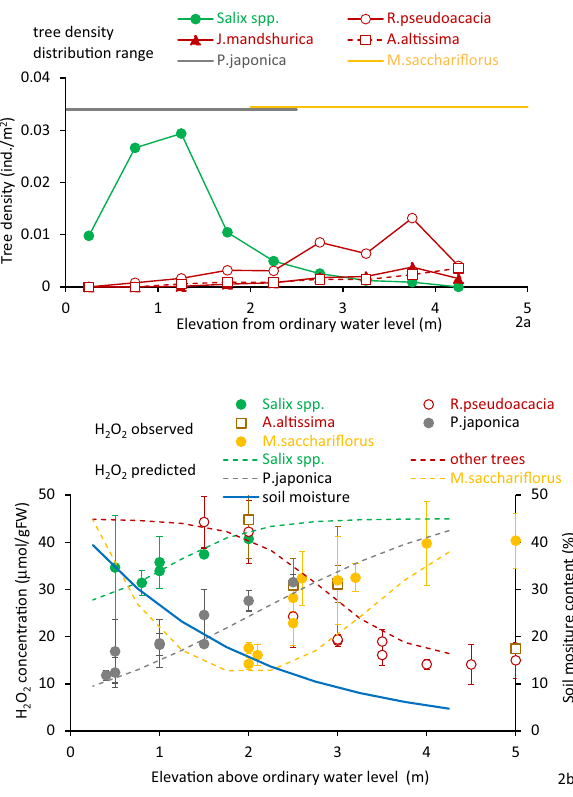
Figure 2. ( a ) Tree density and herb colonies at the Arakawa River site elevations of entire observed area. ( b ) Soil moisture and H 2 O 2 concentration of samples and simulated results from Eqs. (3) to (6) distributions are also shown. Vertical bars in ( b ) are standard